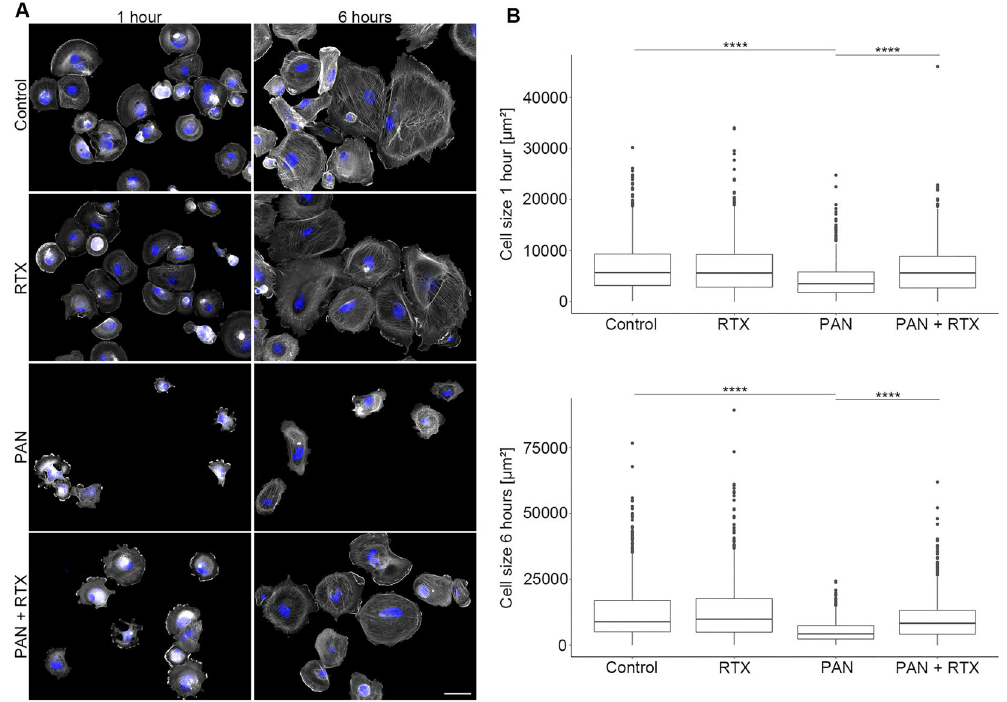
Figure 5. Rituximab results in an increased spreading of human podocytes after post-plating. ( A ) Actin (phalloidin-TRITC, grey) and nuclear (DAPI, blue) staining at 1 and 6 h after post-plating. Scale bar = 50 µm. ( B ) Quantification of cell size 1 and 6 h after post plating. Statistics: Kruskal–Wallis test with Dunn’s multiple comparisons test; the median is shown. ****p < 0.0001; n = 4 experiments; ≥ 300 cells per condition.